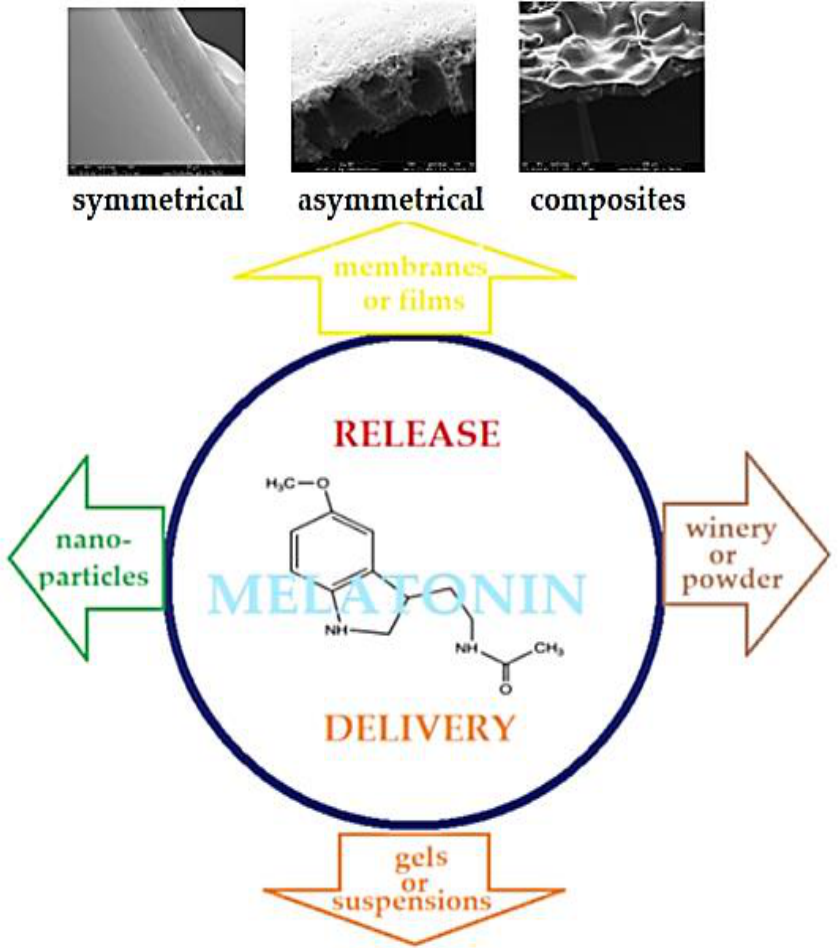
Figure 1. Schematic presentation of interest for chemical species’ (melatonin) release or delivery techniques.